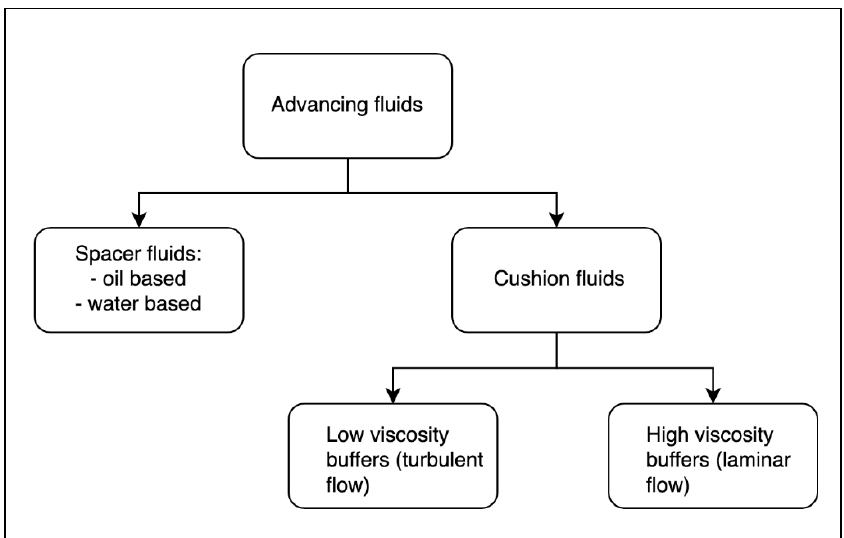
Figure 1. Classification of advancing